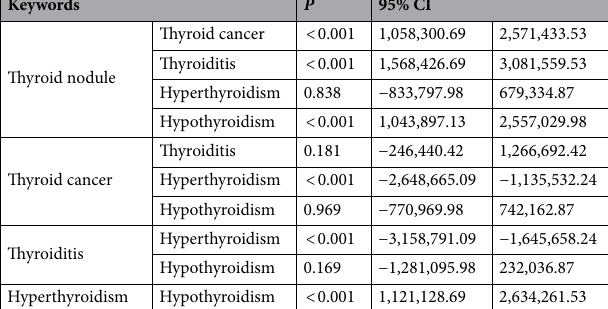
Table 2. Multiple comparisons between keywords (search